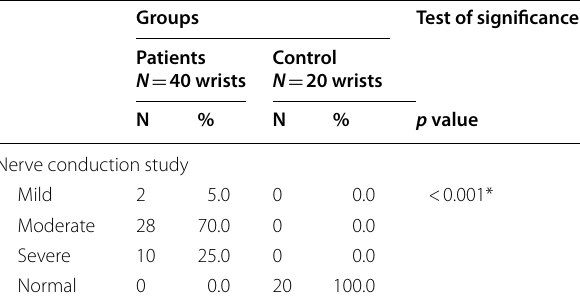
Table 1 Nerve conduction study in the studied patients and control groups